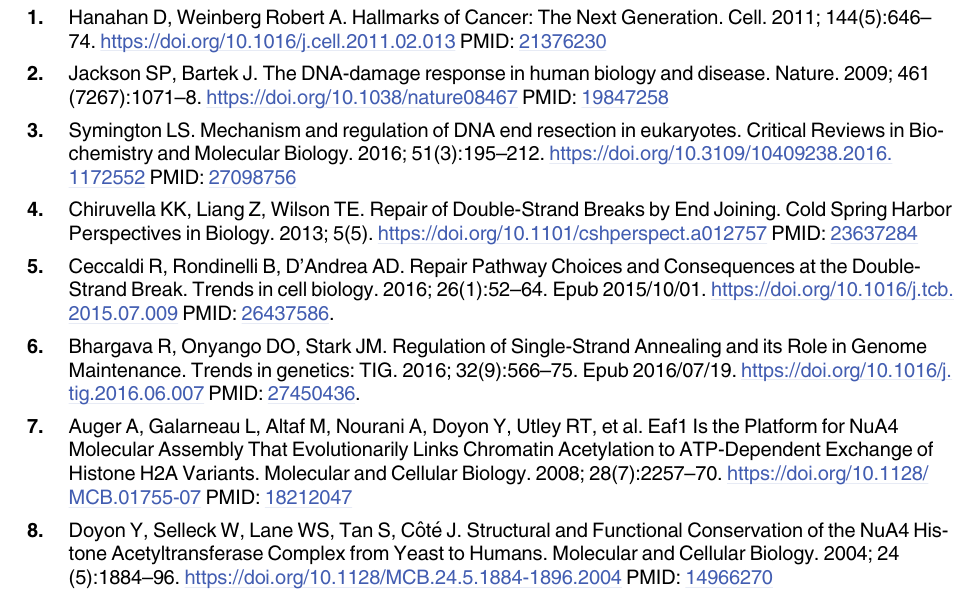
S1 Table. Yeast strains used in the current study. S2 Table. Acetylated peptides detected by mass spectrometry in ESA1 and esa1 ts strains. List of Nej1 peptides containing an acetylated lysine residue confidently identified by mass spectrometry after affinity purification from extracts of WT and esa1 ts cells and trypsin diges- tion. Total peptide sequence coverage obtained were 77 and 83%